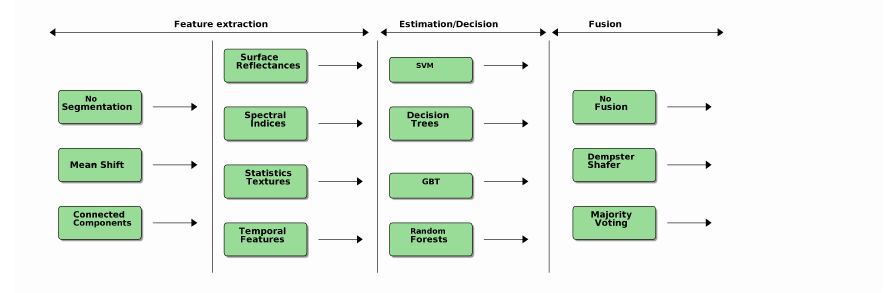
Figure 1. Choices of algorithms leading to strategy